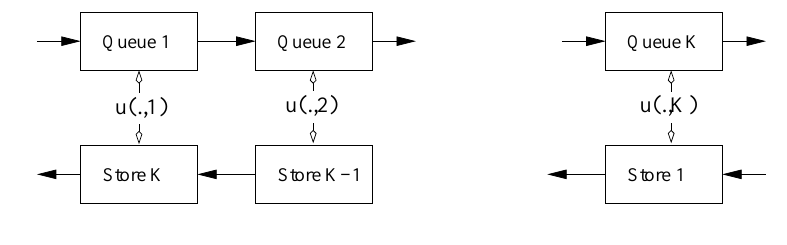
Fig. 6: Queues and stores are gone through in opposite